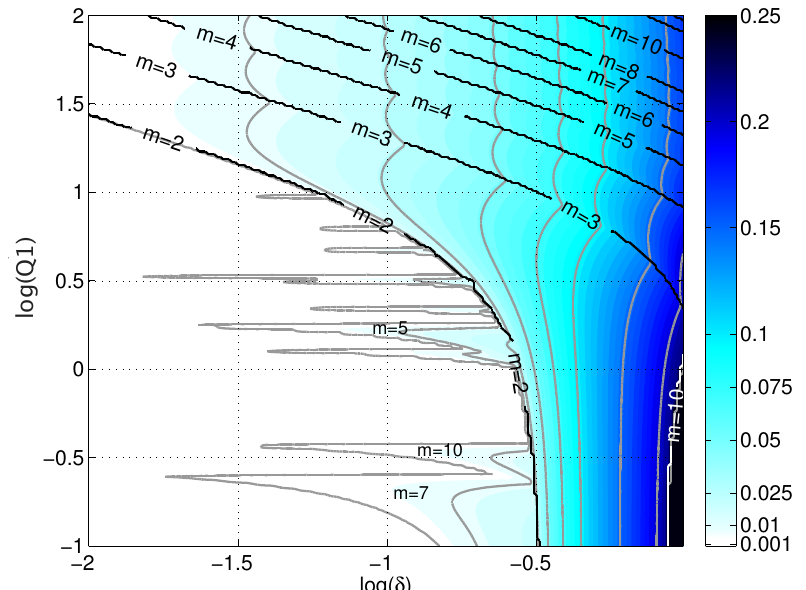
Figure 3. Growth rate (colours) and wavenumber (black contours) of the most unstable mode, as found from the linear stability analysis, in the ( δ , Q 1 ) parameter space, for lenticular vortices with a quiescent lower layer ( V 2 = 0). Following the discussion of realistic parameters (see Section 2.1.3), typical values for large ocean rings are log ( Q 1 ) ∈ [ 0,1.5 ] and log ( δ ) < −